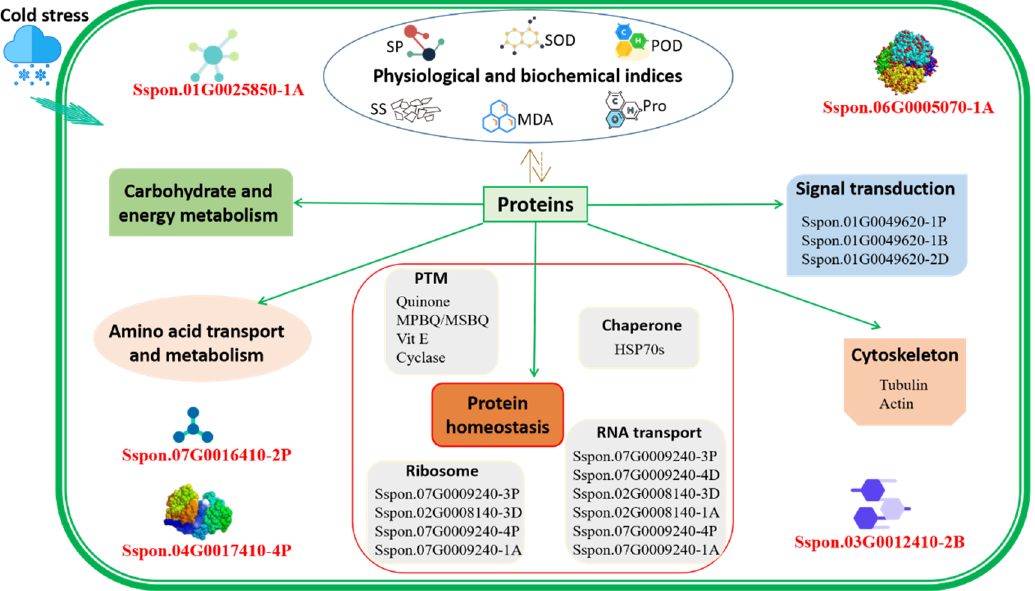
Figure 6. A putative regulatory network of S. spontaneum response to low temperature. Cold stress induces the variation of physiological and biochemical indices, as well as the abundance change in related proteins to coordinate a response. The proteins involved in cold stress response include those in pathways related to protein homeostasis, carbohydrate and energy metabolism, amino acid transport and metabolism, signal transduction, and the cytoskeleton. Five proteins identified for the first time in sugarcane are illustrated in red bold font. PTM, post-translational modification. SP, soluble protein. SS, soluble sugar. MDA, malondialdehyde. SOD, superoxide dismutase. POD, pe- roxidase.